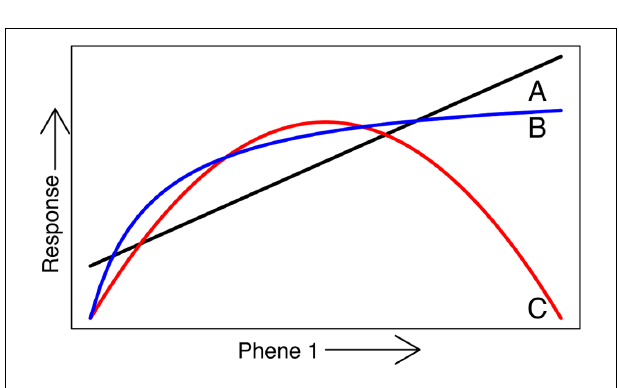
removed from base functions, which themselves can be multi-tiered and reciprocating.The original diagram was made by Arnold (1983) and reworked for plant ecology byViolle etal. (2007). Here we present it for a phene-centric view in agriculture.